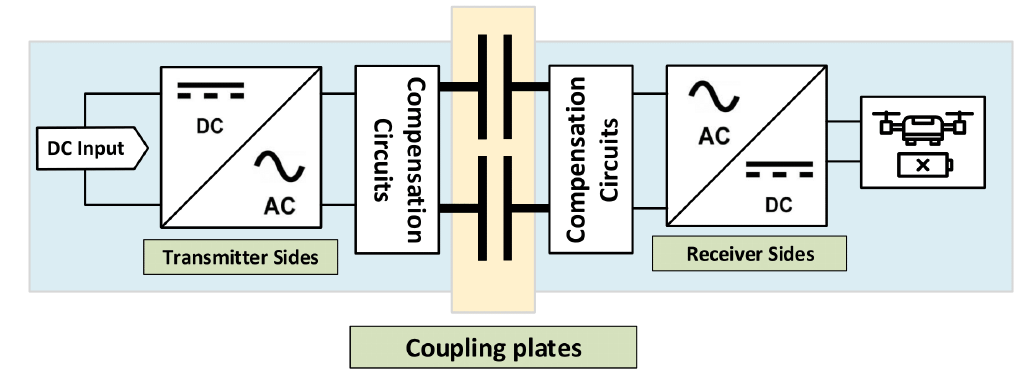
Figure 3. The structure of a typical CCWPT UAVs charging